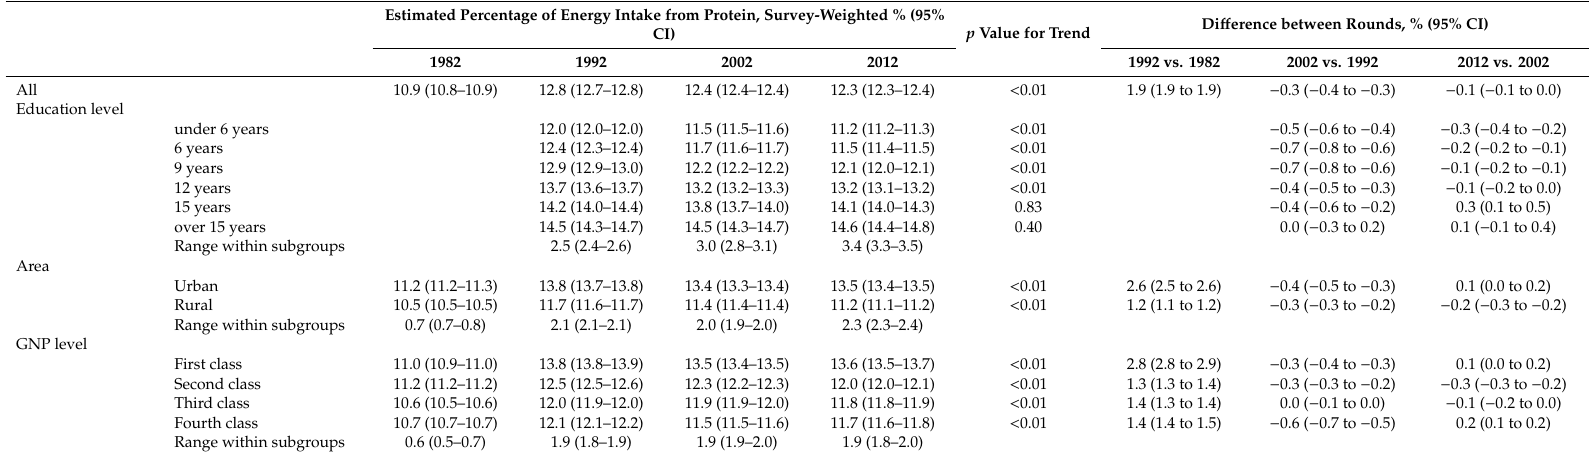
Table 5. Trends and Disparities in the Estimated Percentage of Energy Intake from Protein of Adults Aged 18 Years or Older by CNNS Round, 1982–2012 1 . Estimated Percentage of Energy Intake from Protein, Survey-Weighted % (95%